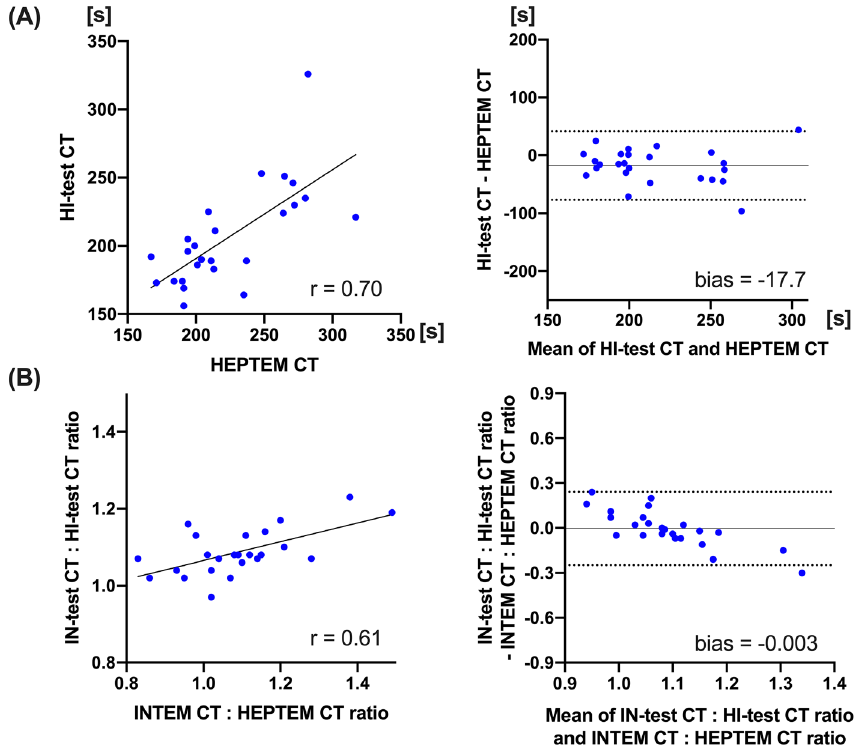
Figure 4. Relationship between HI-test and HEPTEM. Linear regression ( A ) and Bland–Altman analysis ( B ), between HI-test CT and HEPTEM CT. Linear regression ( C) and Bland–Altman analysis ( D ), between IN-test CT:HI-test CT ratio and INTEM CT:HEPTEM CT ratio. Solid line in Bland–Altman analysis depicts bias, and dotted lines depict 95% limits of agreements. CT clotting